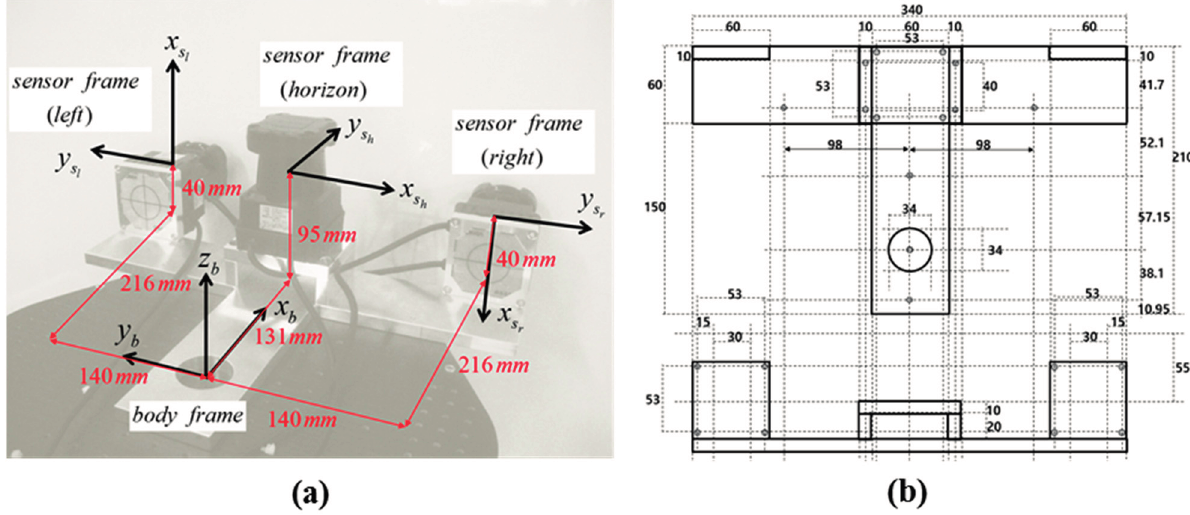
Figure 3. ( a ) Lever-arm parameters and ( b ) design drawing of the sensor